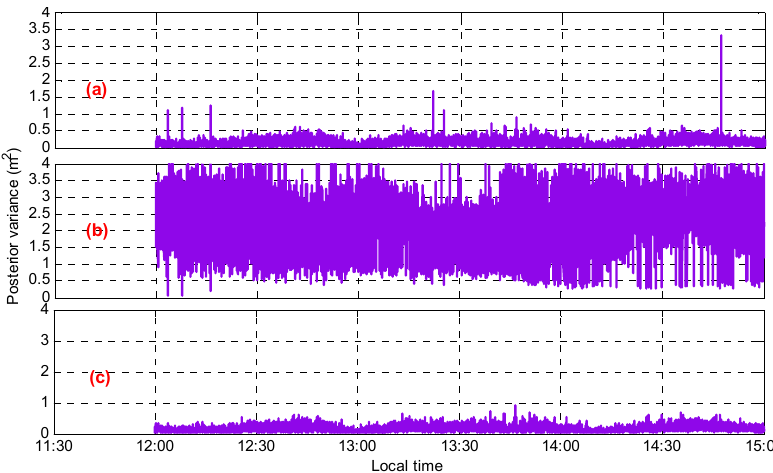
Figure 10. The performance for the posterior variance ( a ) with the initial ambiguity, ( b ) with the candidate ambiguity, and ( c ) with the final ambiguity.